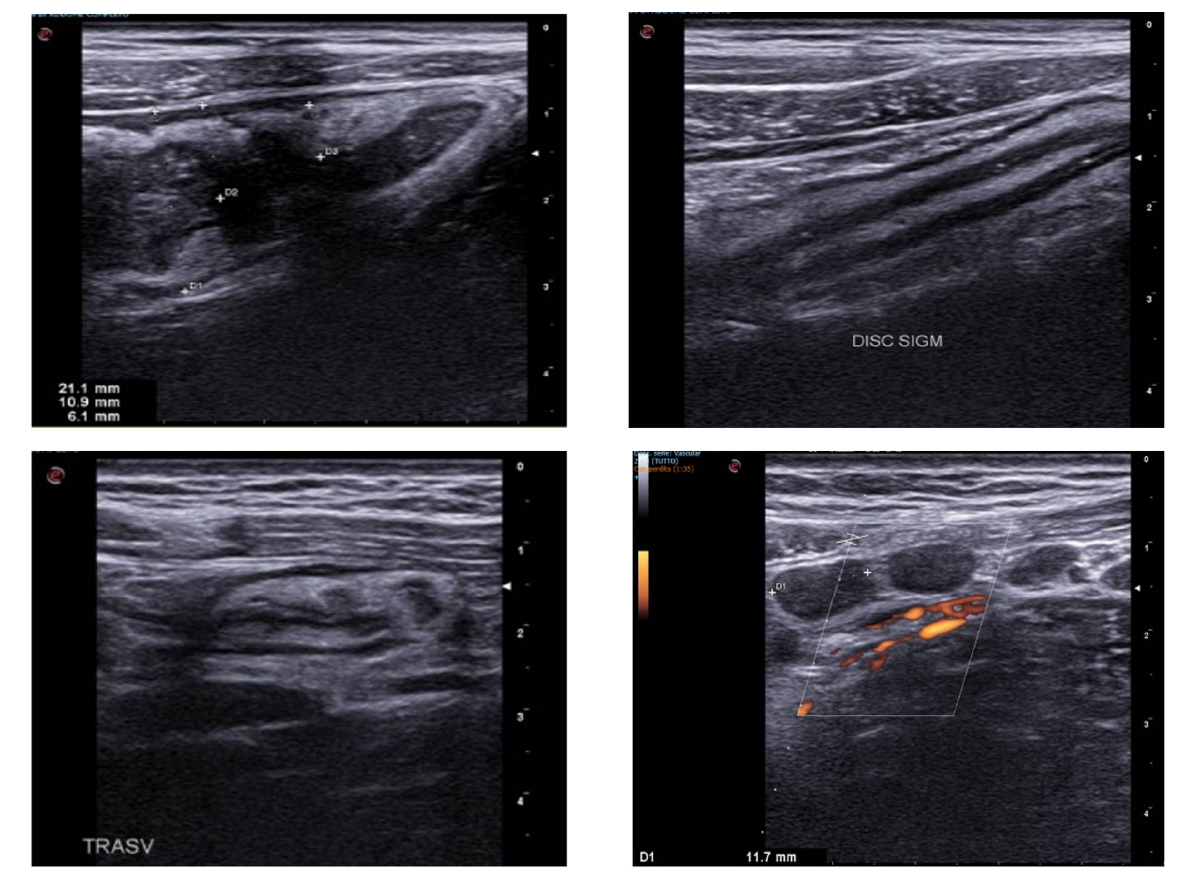
Figure 4. Patient went to the emergency room reporting diffuse abdominal pain for about 10 days associated with diarrhea and traces of blood and mucus, and weight loss (about 10 kg). GIUS showed diffuse wall thickening of the entire colon, particularly at the level of the ileocecal valve (11 mm) and submucosa thickness of 6 mm; multiple lymph nodes were evident in the right iliac area, with a maximum size of 11 mm. The clinical and ultrasound findings are compatible with Crohn’s disease.